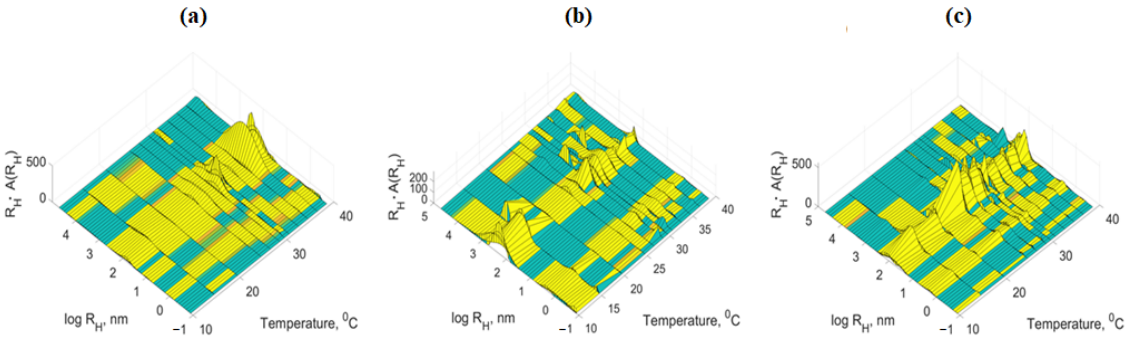
Figure 4. DLS results of POX 1200 ( a ), POX 2000 ( b ), and POX 4700 ( c ) dissolved in water at room temperature.